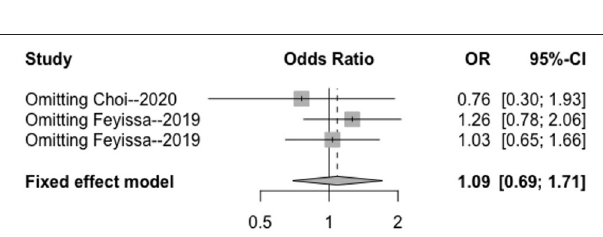
FIGURE 8 | Sensitivity analysis of the correlation between MGMT methylation and perioperative epilepsy. CI, confidence interval; MGMT, O6-methylguanine-DNA methyltransferase; OR, odds ratio.